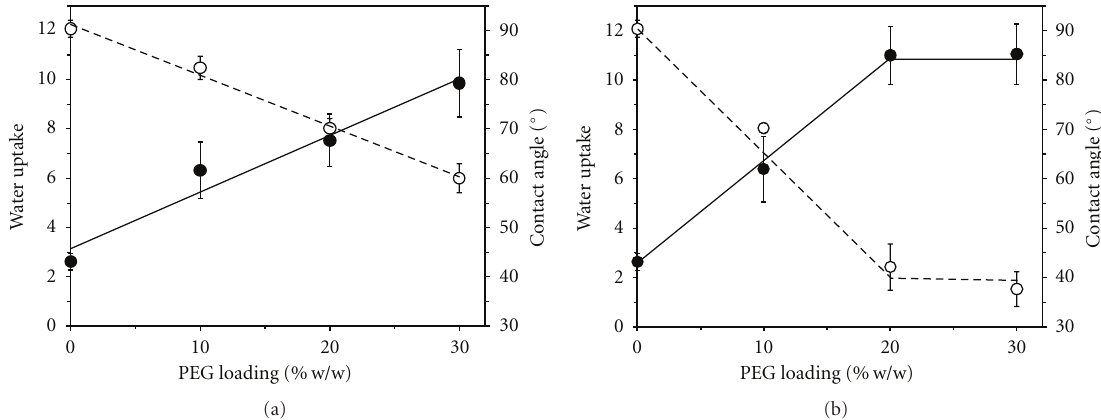
Figure 6: Change in water contact angles ( • ) and water uptakes ( ◦ ) for PHB/PEG composite films with di ff erent PEG loadings (% w/w), (a) PEG106 and (b)